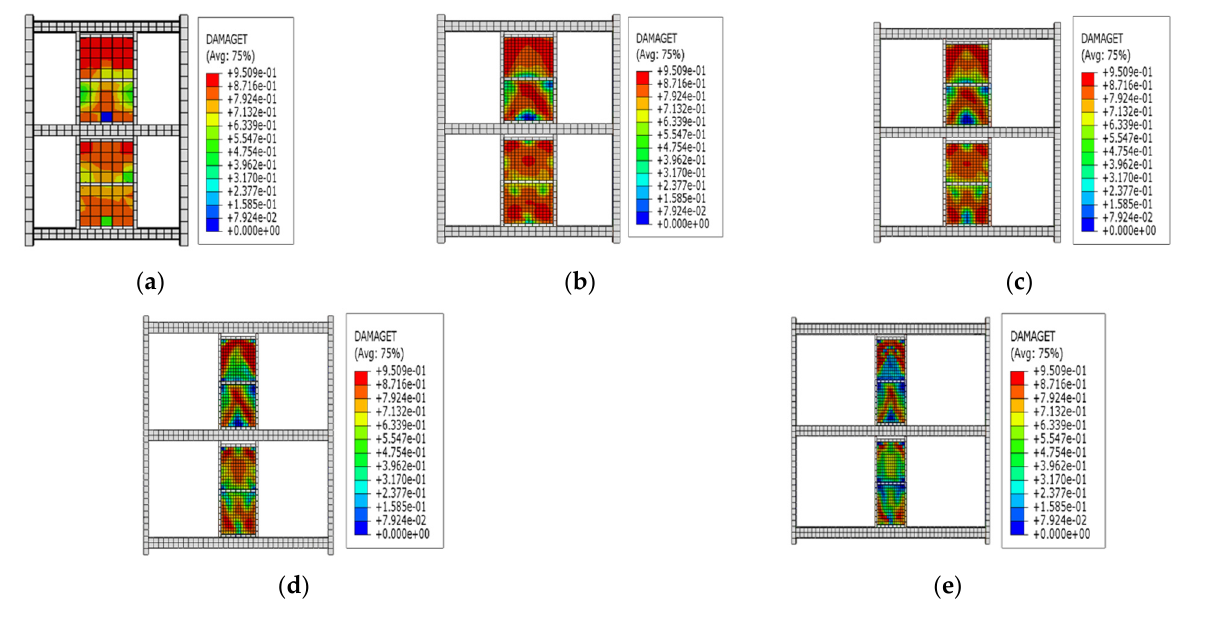
Figure 14. Stress contour plots of the first group of frames with the EDCWs at failure. ( a ) F1; ( b ) F2; ( c ) F3; ( d ) F4; and ( e ) F5.